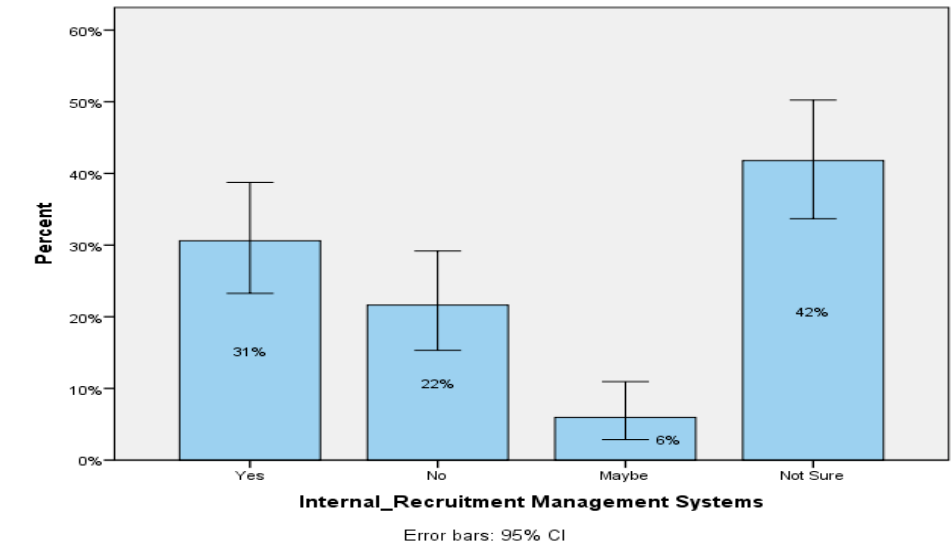
Figure 6. Use of IT Systems.